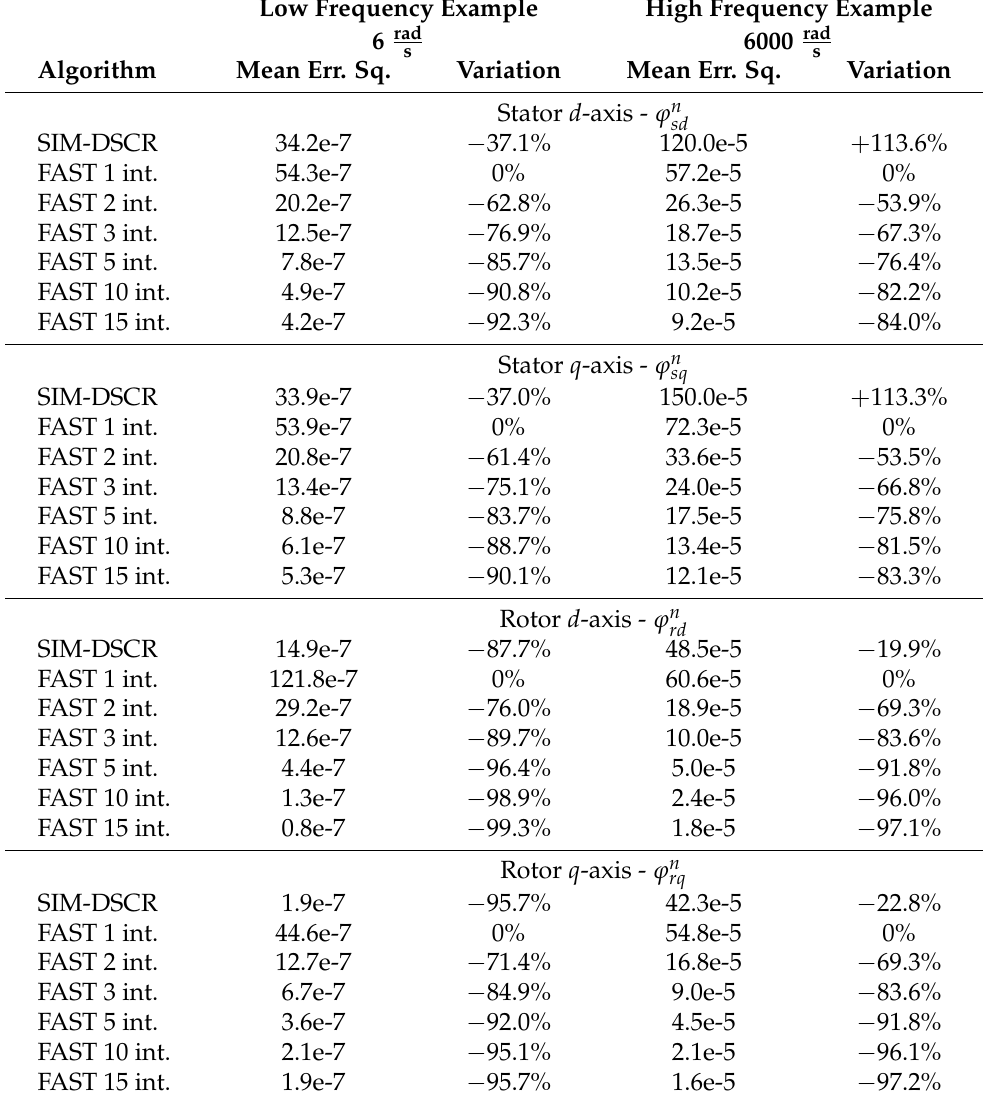
Table 2. Mean error squared results of low and high frequency simulations. Base error is the one of the 1 sub-interval